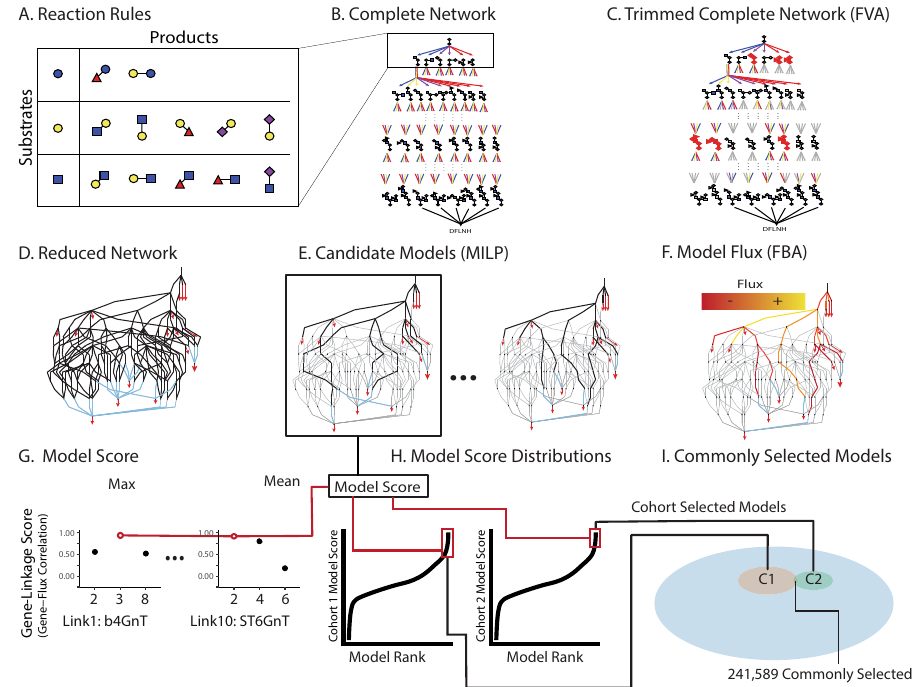
Fig. 3 HMO biosynthesis models constructed with fl ux analysis and ranked by expression concordance perform consistently across cohorts. Overview of computational methods for model assembly (A – F) and assessment (G – I). A To build the candidate models of HMO biosynthesis, reaction rules were de fi ned to specify all possible monosaccharide additions. B The Complete Network includes all oligosaccharides and irreversible reactions resulting from the iterative addition of monosaccharides to a root lactose. C Using Flux Variability Analysis (see Supplementary Methods 5.4), the Complete Network was trimmed, removing reactions that cannot reach experimentally-measured HMOs, to produce a Reduced Network D (Supplementary Fig. 10); red triangles are observed HMOs blue lines are “ sink reactions ” joining alternative isomers (Supplementary Fig. 5). E From the Reduced Network, Mixed Integer Linear Programming (MILP) was used to extract candidate models, each representing a subnetwork capable of uniquely synthesizing the